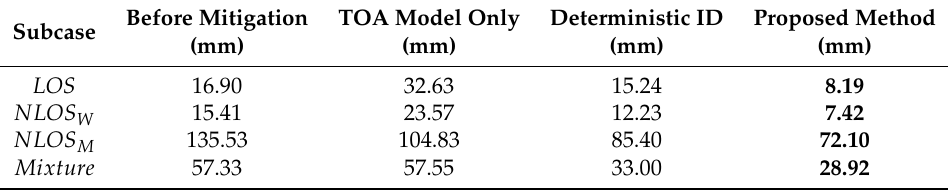
Table 1. Mean ranging errors in an inter-robot ranging experiment. The best result in each row is highlighted in bold .